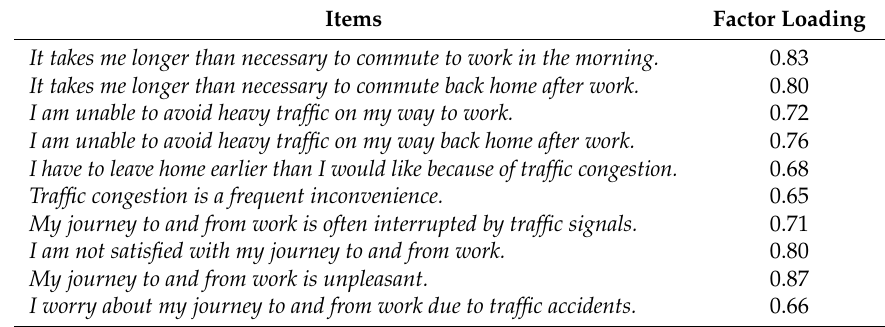
Table 6. Final items of the commuting stress (CS) scale and their standardized factor loadings.